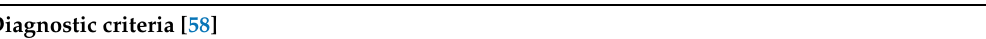
Table 2. Diagnosis of histamine